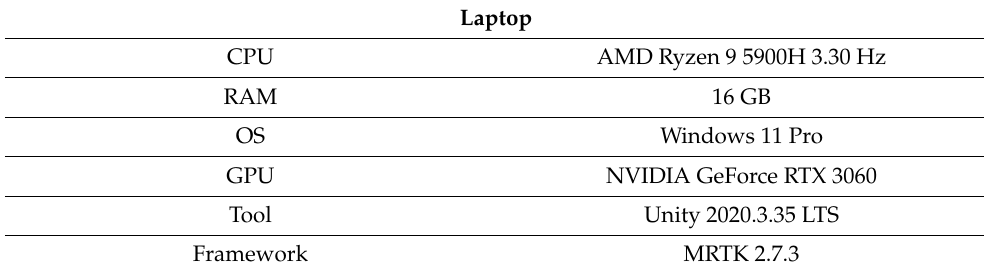
Table 1. Mixed reality system specifications.